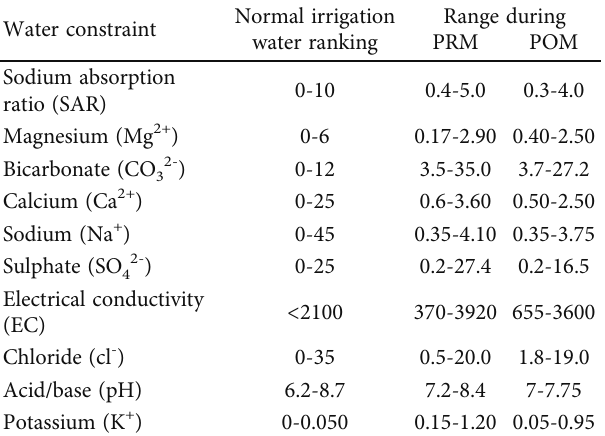
Table 7: Guidelines for interpreting the quality of irrigation water. Normal irrigation Water constraint water